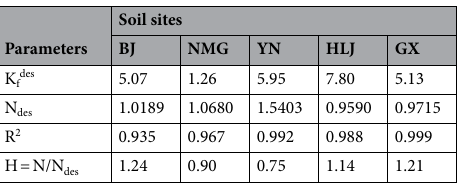
Table 3. Freundlich parameters and hysteresis coefficient for desorption of QUN.